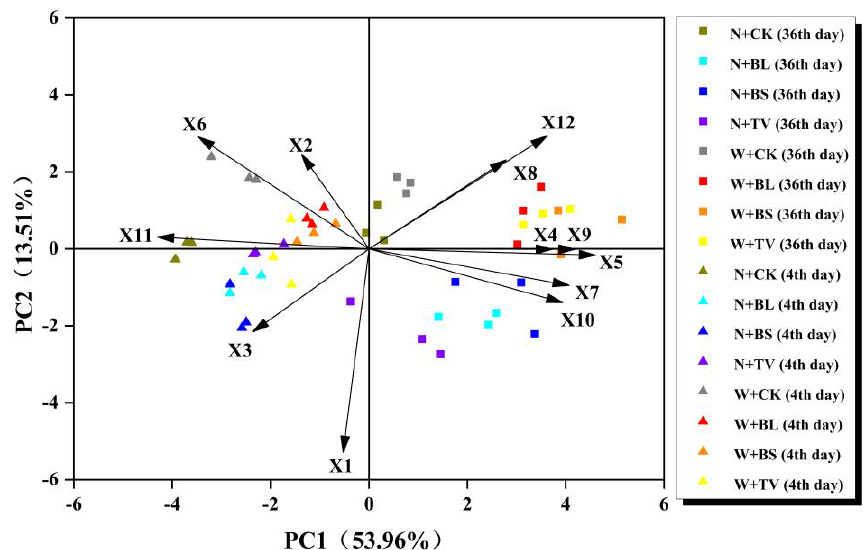
Figure 12. Principal component analysis in the treatments. X1: pH; X2: EC value; X3: E4/E6